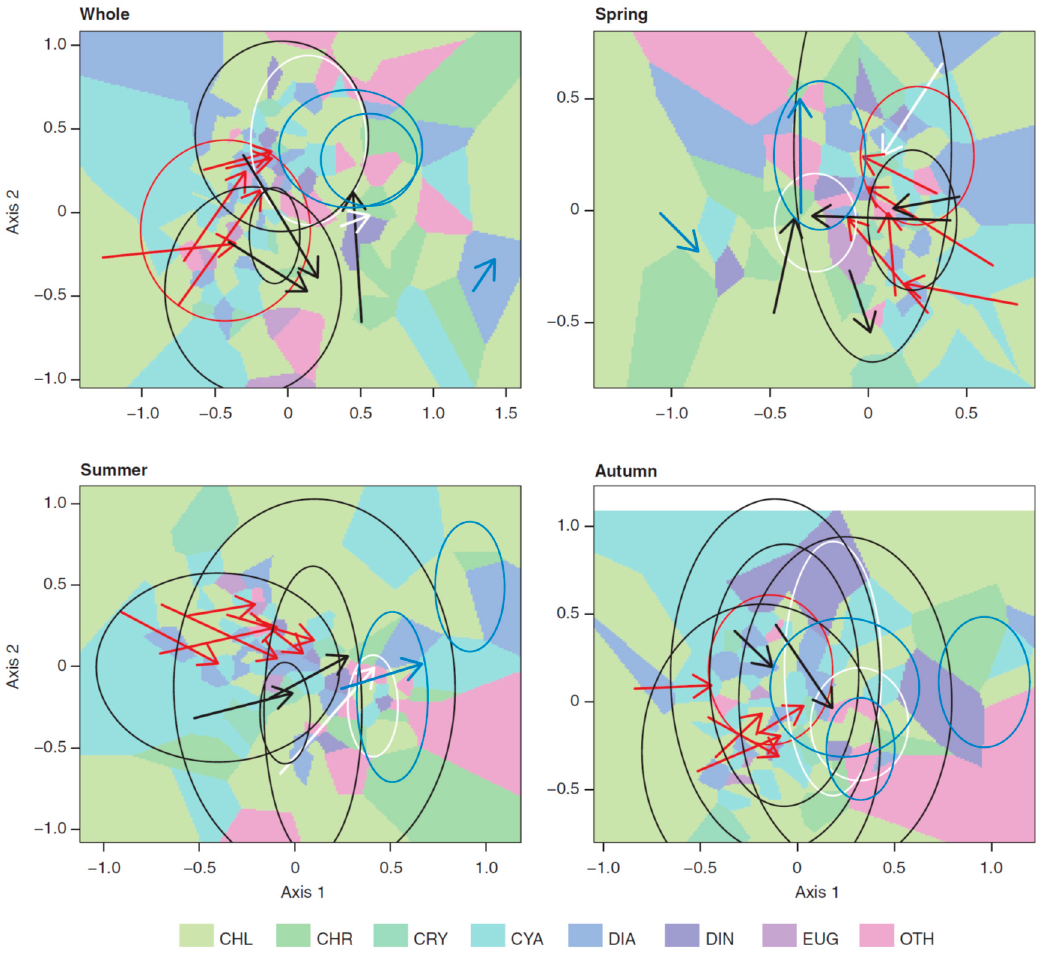
Figure 6. Non ‐ Metric Multidimensional Scaling (NMDS) ordination of annual and seasonal phytoplankton assemblages. Following the ordinations taxa scores were aggregated for main groups, and Voronoi polygons were plotted for each main group. The legend explaining which colour represents which phytoplankton group was given below the figure. The colours in the background represent the compositional surface of the phytoplankton assemblages in all lakes. Temporal change in assemblage composition is displayed by an arrow for lakes with significant change between years. Compositional variation in lakes without significant change is indicated with an ellipse. Blue, black and red are used for N, W and S lakes, respectively, for the arrows and ellipses. Two lakes not included in any of the groups are indicated with white. For details see Figure 4.